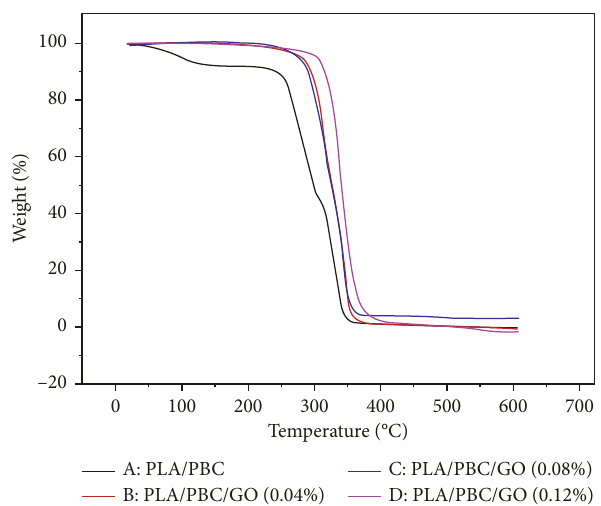
Figure 2: TG thermograms of GO/PLA/PBC nanofibers.